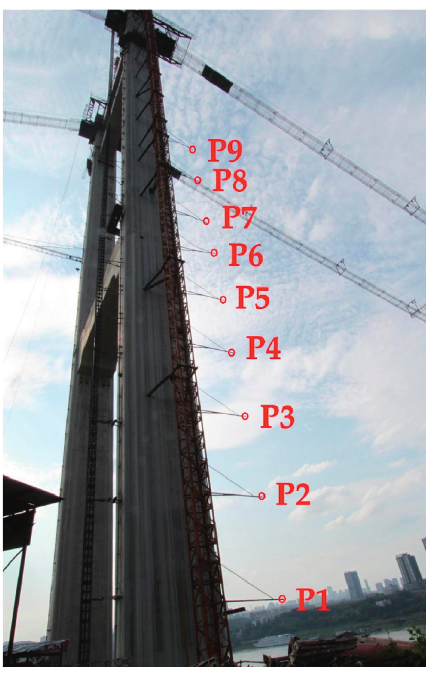
Figure 3: The measurement station where the sensors are installed on the construction crane of the south tower and P 1– P 9 denote the measuring